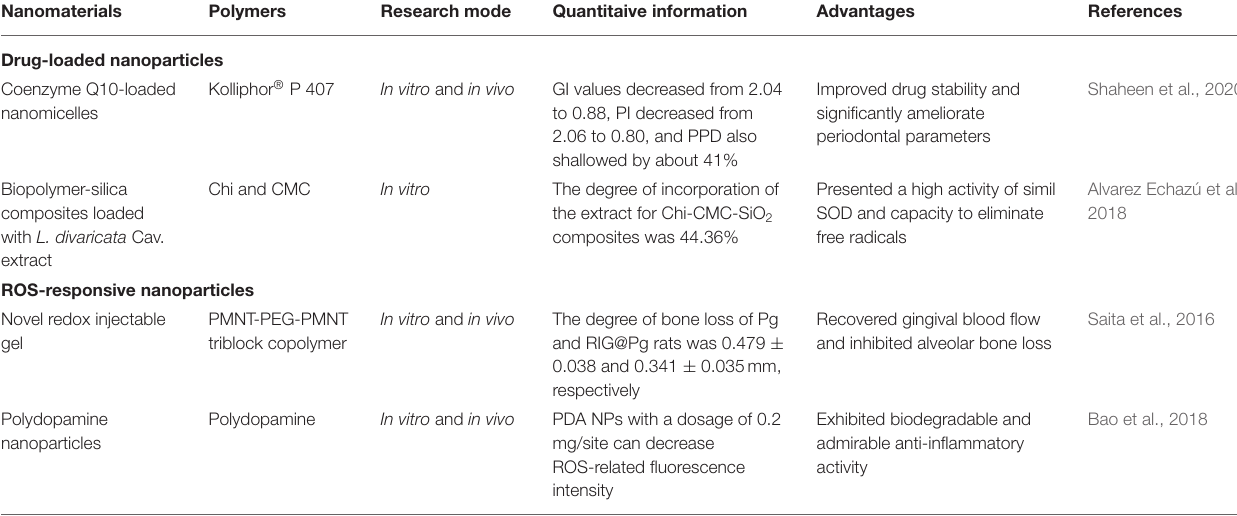
TABLE 1 | Applications of ROS-scavenging nanomaterials to treat